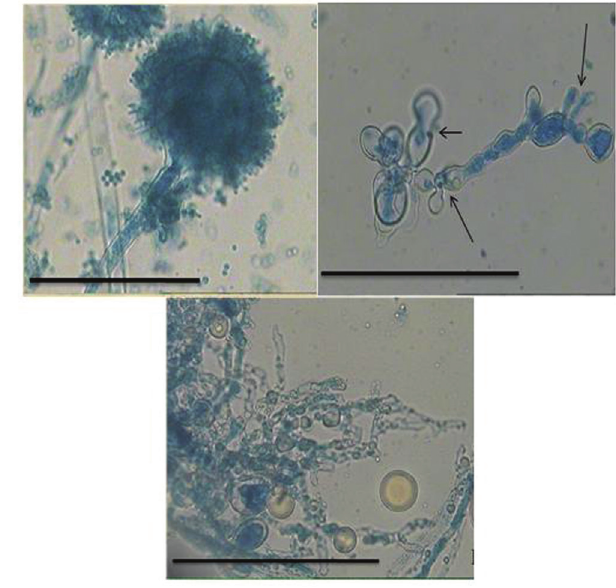
FIGURE 4 - Light microphotographs of A. flavus LM-02 mycelium growing on AS with or without O. vulgare (80 µL/ mL) essential oil during 7 days of incubation at 25-28 °C. (a) Control conidial head of A. flavus , large and radiated, development of vesicle on conidiophore, conidia clearly visible, Bar 100 µm. (b) (b-c) Hyphae modification induced by O. vulgare essential oil showing anomalous structure with bud-like formation and loss of pigmentation; clear leakage of cytoplasm content and destruction of cell structure evidenced by disrupted hyphae integrity, Bar 100